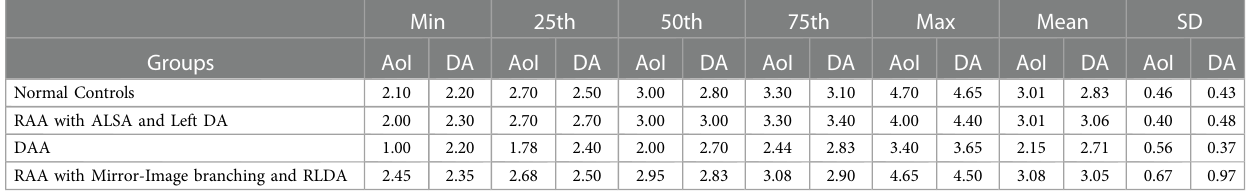
TABLE 2 The tabular summaries of mean, SD, minimum, maximum, median, and 25th and 75th percentile from the base data of AoI and DA diameter (mm) respectively. Min Groups Normal Controls RAA with ALSA and Left DA DAA RAA with Mirror-Image branching and RLDA AoI, aortic arch isthmus; DA, ductus arteriosus; Min, minimum; Max, maximum; SD, standard deviation; RAA with ALSA and left DA, right aortic arch with aberrant left subclavian artery and left ductus arteriosus; DAA, double aortic arch; RAA with mirror-image branching and RLDA, RAA with mirror-image branching and retroesophageal left ductus